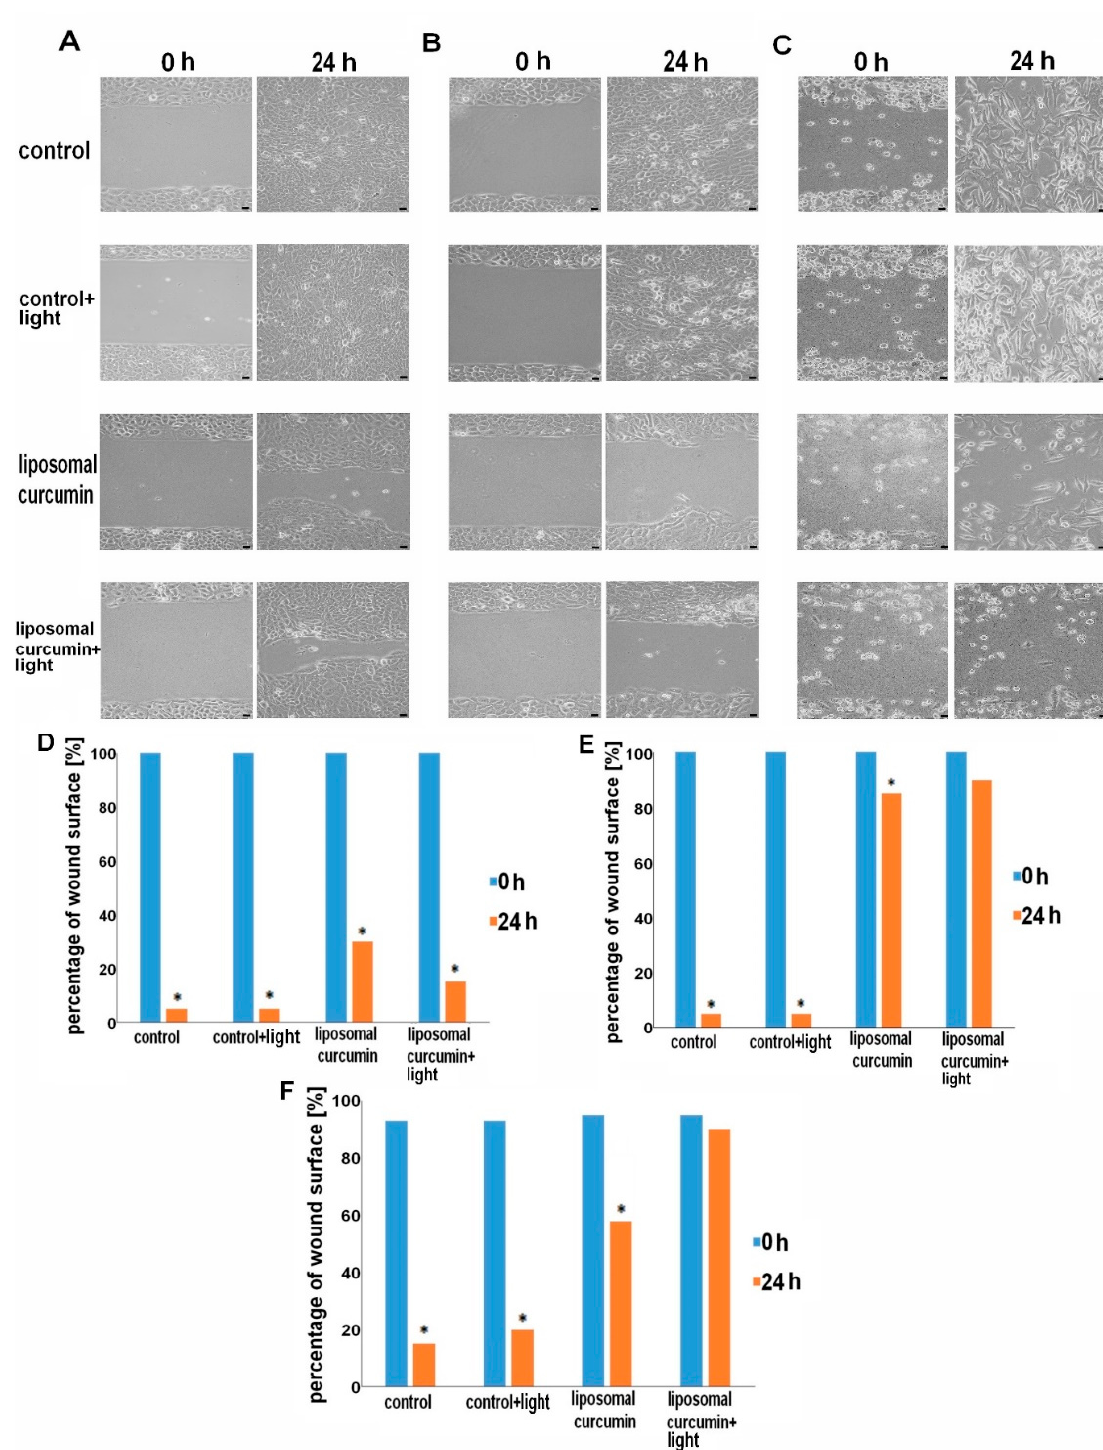
Figure 3. Wound-healing assay in time point 0 h and 24 h of ( A ) HaCaT, ( B ) SCC-25, and ( C ) MUG-Mel2 cell line. Representative images show that, after 24 h, the scrap in control cells is minimal compared to cancer cells treated with liposomal curcumin in dose 10 µ M with blue light (2.5 J/cm 2 ). In treated cells, in the HaCaT control cell line, the scrap is smaller than in the other two cancer cells ( D – F ). ( D ) Quantification of cell migration for HaCaT, SCC-25, and MUG-Mel2 cells. Results are presented as the percentage of the wound surface. The initial wound area is expressed as 100% at 0 h. Results represent the mean from three different experiments. Scale bar = 50 µ m. * p <